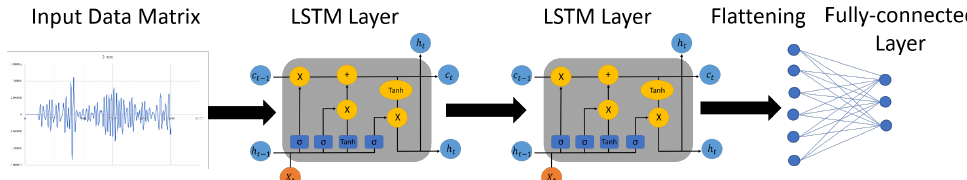
Figure 12. Graphic representation of the LSTM’s configuration, chosen after the optimization process, with two